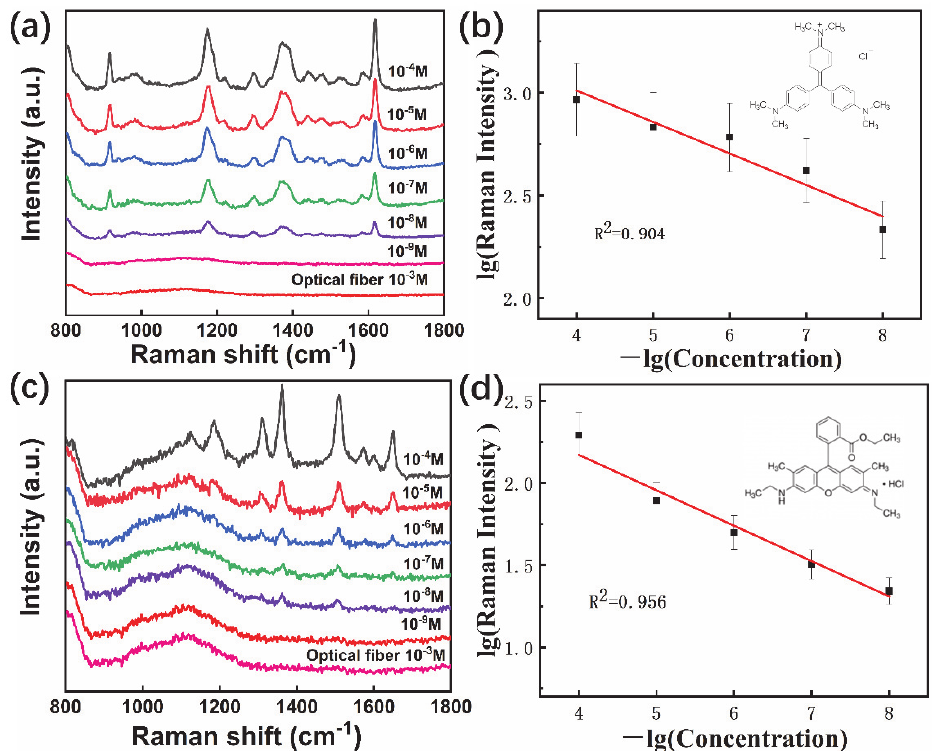
Figure 7. Raman spectra of CV molecules with concentrations from 10 − 4 M to 10 − 9 M, using SERS fiber probes, under 633 nm laser excitation ( a ), and the relationship between CV concentrations and 1619 cm − 1 peak intensities ( b ), Raman spectra of R6G molecules with concentration from 10 − 4 to 10 − 9 M ( c ), and the relationship between R6G concentrations and 1361 peak intensities ( d ). The optical fiber in ( a , c ) indicated Raman spectrum of 10 − 3 M CV or R6G using naked fiber. The enhancement factor (EF) of fiber probe could be calculated using Equation (1) from Gupta